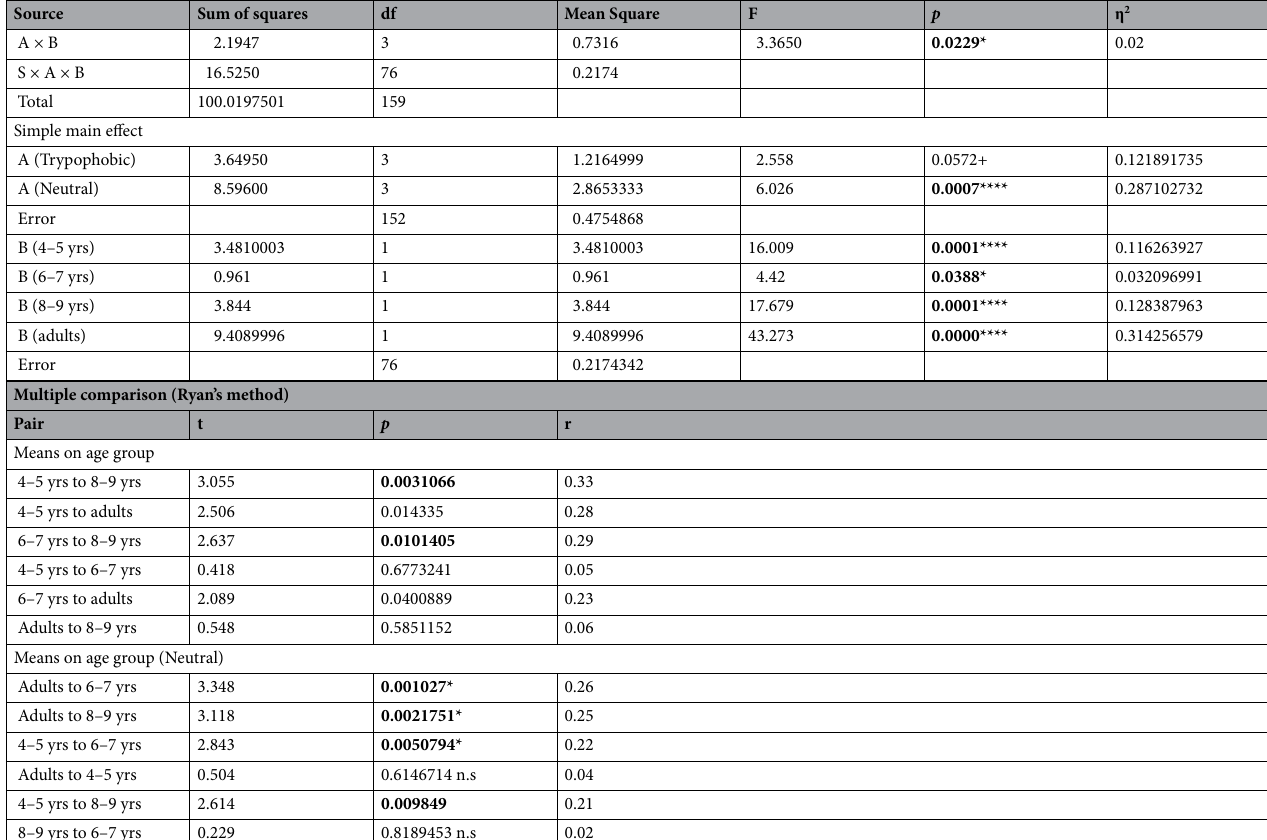
Table 2. Results of two-way mixed analysis of variance of the mean scores for (a) disgust, (b) fear, (c) feel itchiness, and (d) like, with image type (trypophobic and neutral) as a within-group factor and age group (4–5 years, 6–7 years, 8–9 years, and adult) as a between-groups factor. + p < .10, * p < .05, ** p <.01, *** p < .005, **** p < .001 MSe = 0.405766, df = 76, significance level = 0.050000 MSe = 0.475487, df = 152, significance level = 0.050000 Significant values are in